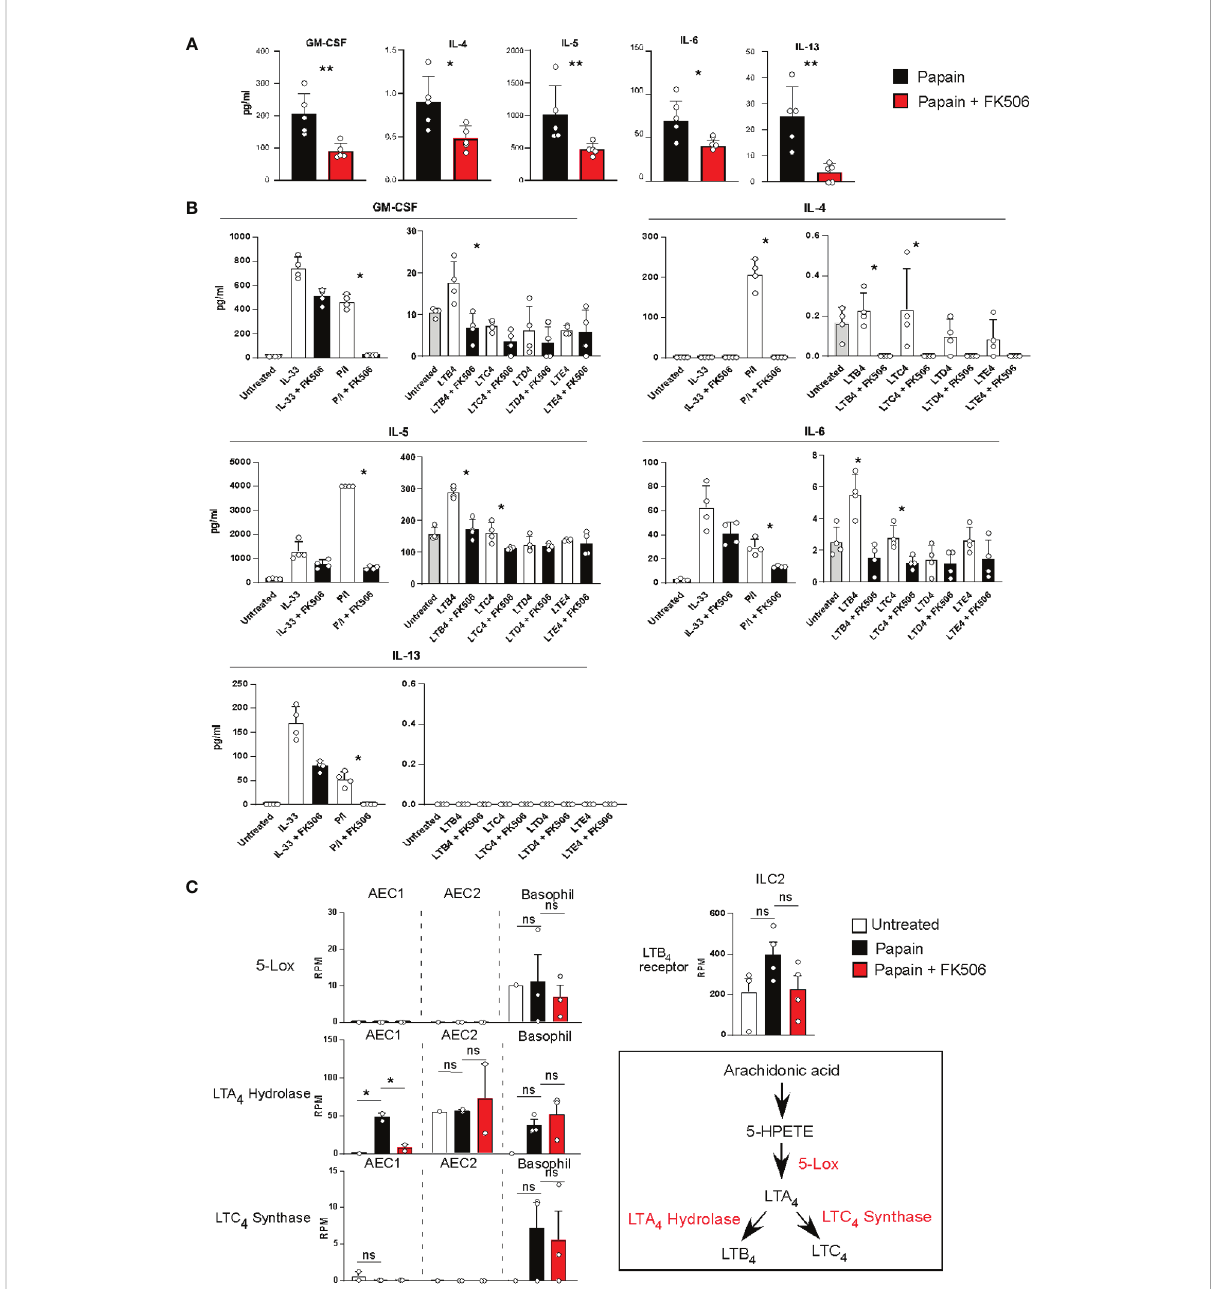
FIGURE 5 (A) Lung ILC2 cells were isolated from papain-administrated mice treated with (n=5) or without (n=5) FK506 and were cultured in the presence of rIL-7 for 12 h. Cytokine and chemokine levels in the cell supernatants were measured using MAGPIX System. (B) Pooled ILC2 cells were isolated from the lung of 20 unstimulated mice. Ten thousand cells were cultured on a 96-well plate in the presence of rIL-7 for 40 h. The cells were activated with LTs, IL-33, or PMA + ionomycin treated with (n=5) or without FK506 (n=5). Levels of type 2 cytokines were assessed as described above. (C) The left panel indicates the expression of lipid mediator genes in AEC1 cells (n=3), AEC2 cells (n=3), and basophils (n=3). The right-top panel indicates the expression of the LTB4 receptor in lung ILC2 cells as described in Figure 4. The right-bottom panel represents the biosynthetic pathway of LTB4. Bars represent the means; not signi fi cant (ns), *p – 0.05, **p – 0.01 using unpaired Mann-Whitney U-tests. All error bars represent the